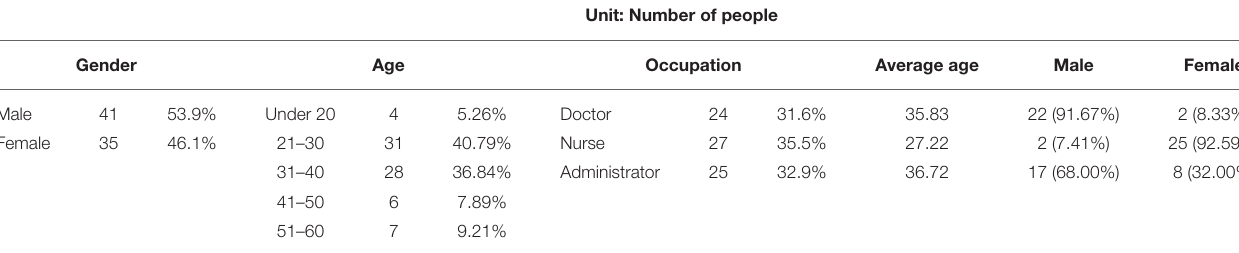
TABLE 2 | Attributes and proportion of staffs.